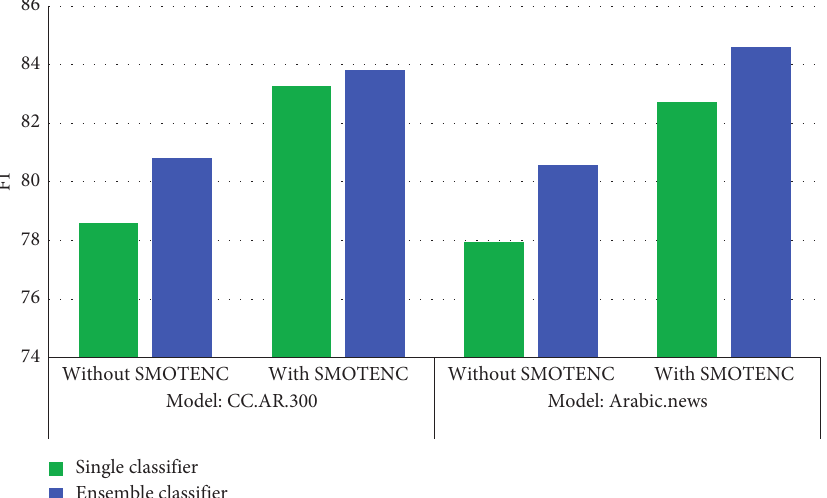
Figure 3: Average of F 1 score for single-based and ensemble-based classifiers with and without